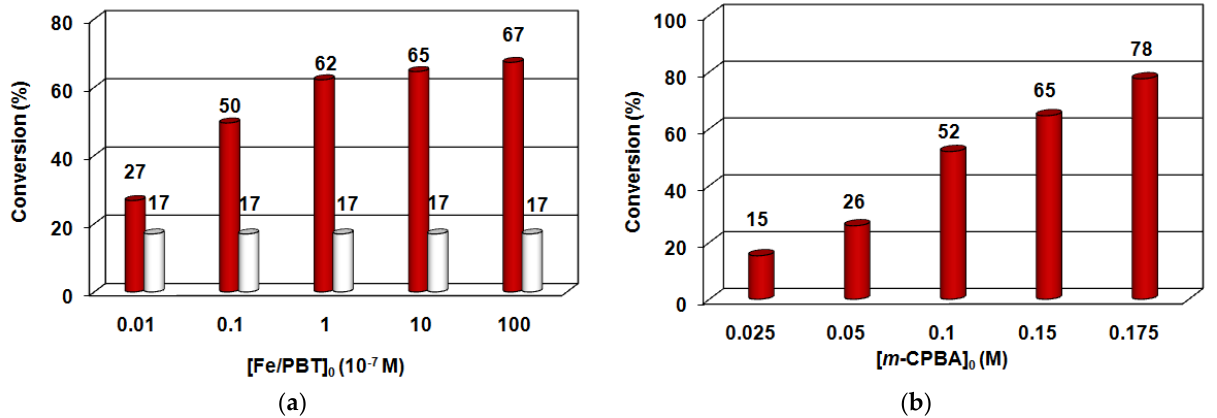
Figure 5. Preliminary kinetic study on the iron(II)-catalyzed Baeyer–Villiger oxidation of cyclohex- anone by mCPBA. ( a ) Plot of conversion versus catalyst ( 2 ) concentration; ( b ) Plot of conversion versus mCPBA concentration Reaction conditions: [ 2 ] (0.01–1.0 × 10 − 7 M), cyclohexanone (10 mM), benzaldehyde (25–175 mM), CH 3 CN (5 mL), 60 °C, 5 h.